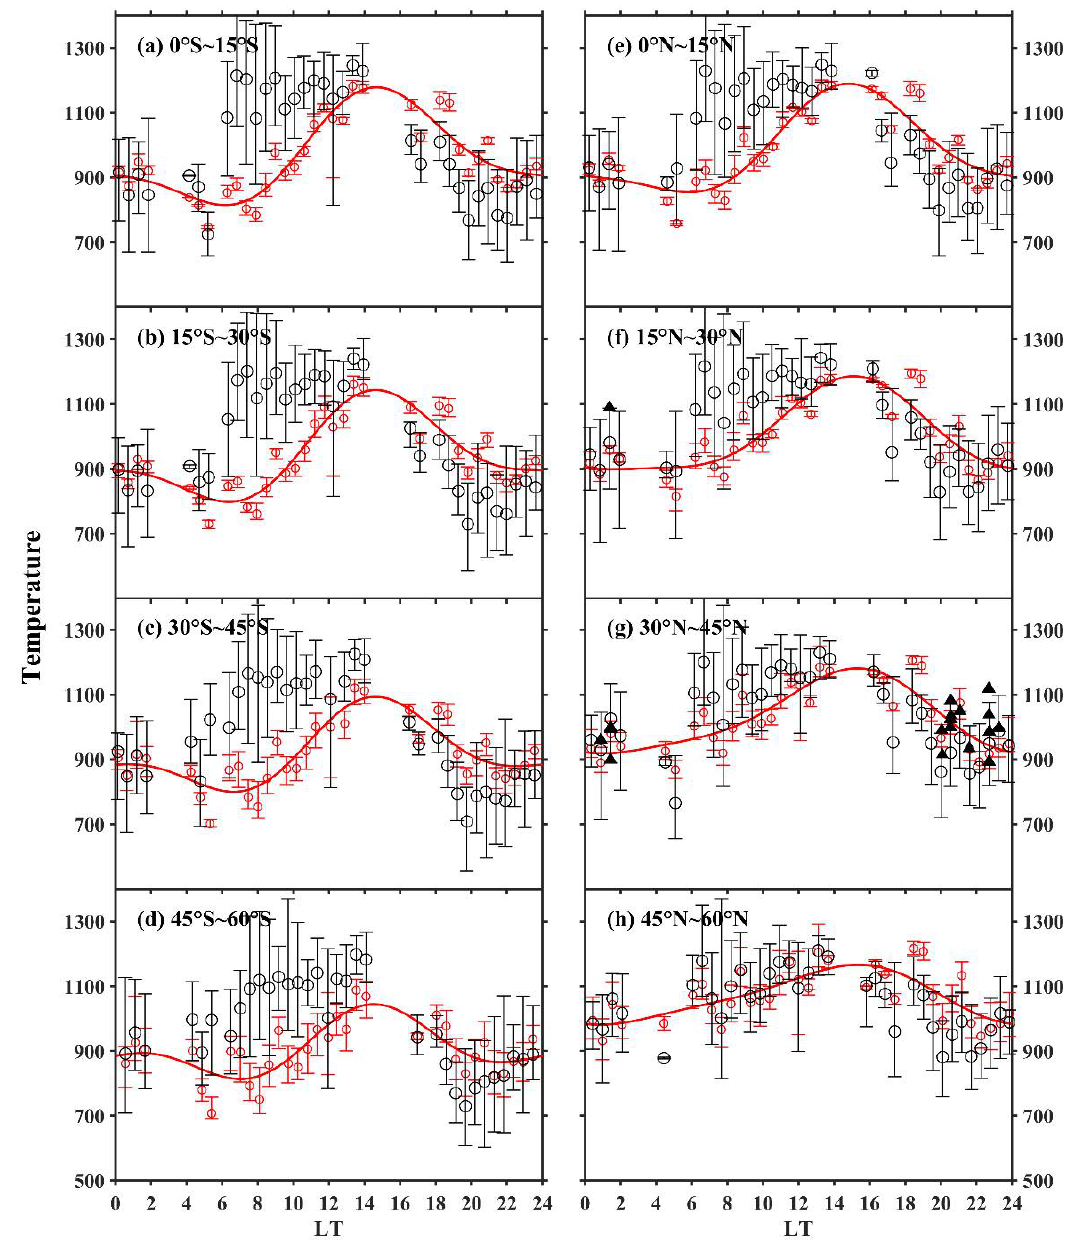
Figure 6. Diurnal variation of derived temperatures calculated with m 0 , model temperatures and ground-based FPI temperatures. The duration is from mid-April to early August in 2014. Black dots represent the derived temperatures, red dots represent the MSIS temperatures, red line represents the fitted curve of red dots; and black solid triangles represent the ground-based FPI temperatures during this time. The left side represents the four latitude bands of the Southern Hemisphere, and the right represents the Northern Hemisphere.